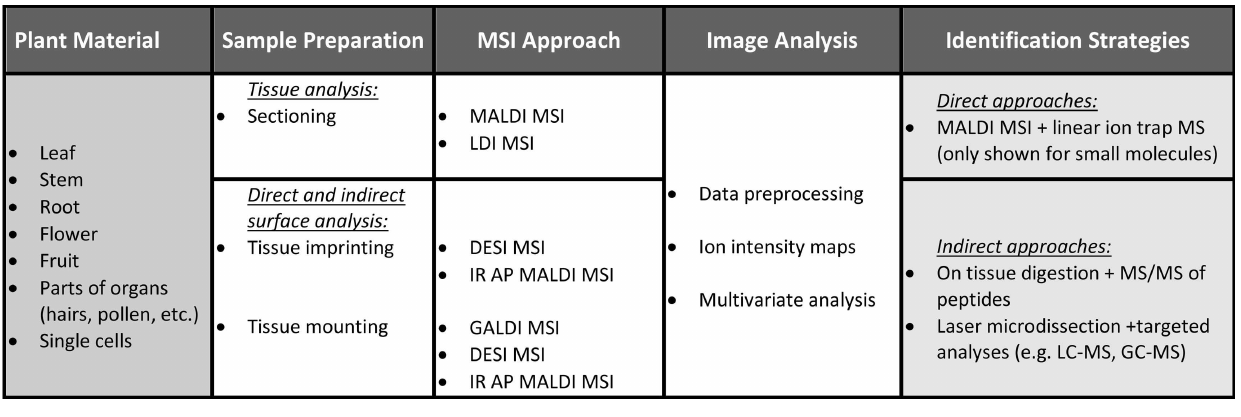
For molecular species targeted by the different approaches please refer also to Table 1